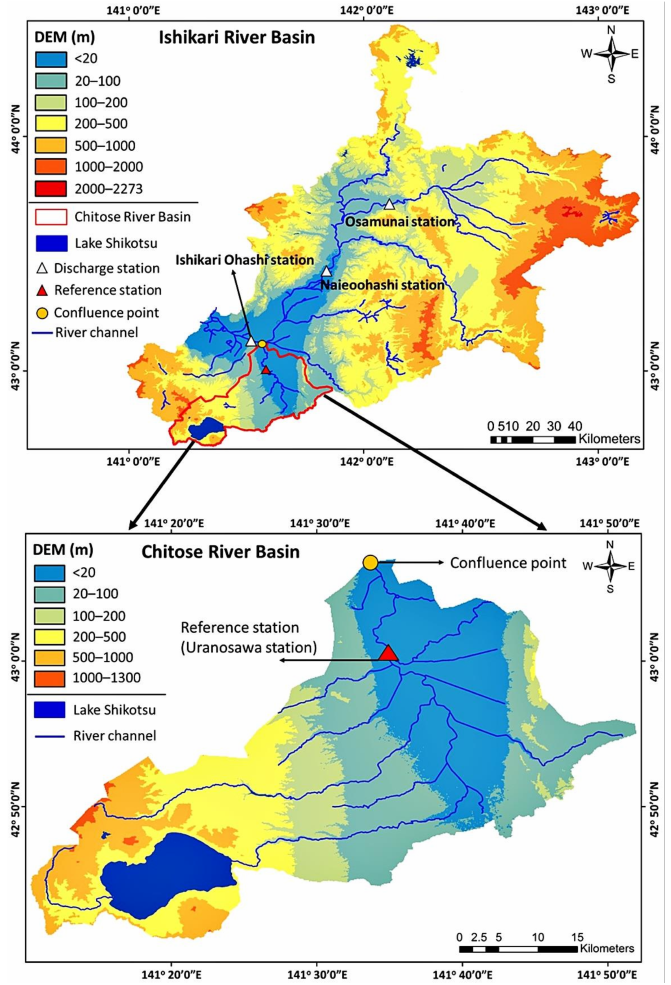
Figure 1. Locations of the Ishikari River basin and Chitose River